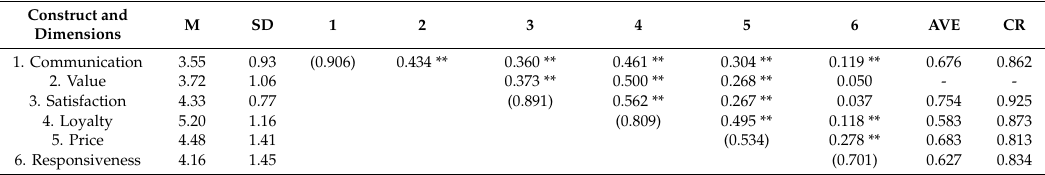
Table 3. Descriptive statistics, internal consistency (diagonal), intercorrelations for study variables between extracurricular sports activities, Average Variance Extracted (AVE), and Composite Reliability (CR) ( N = 1080).